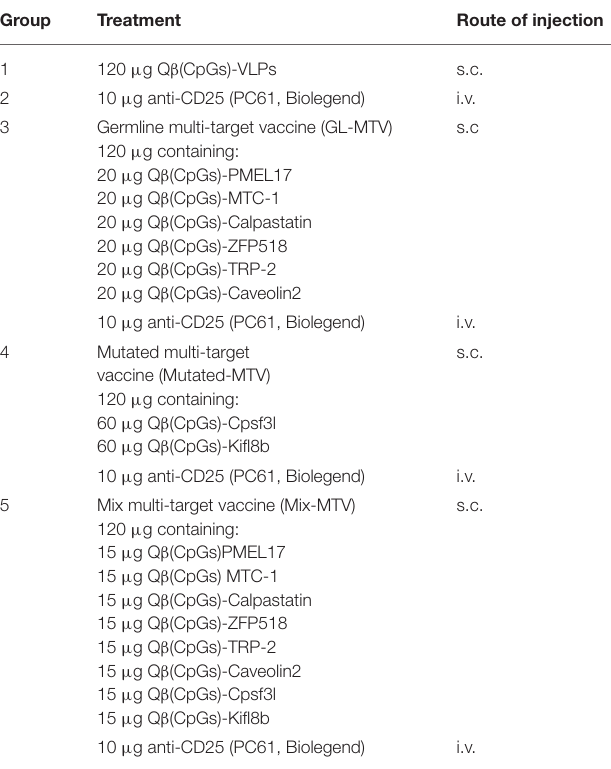
TABLE 1 | The prepared groups, treatment, and route of injection. Group